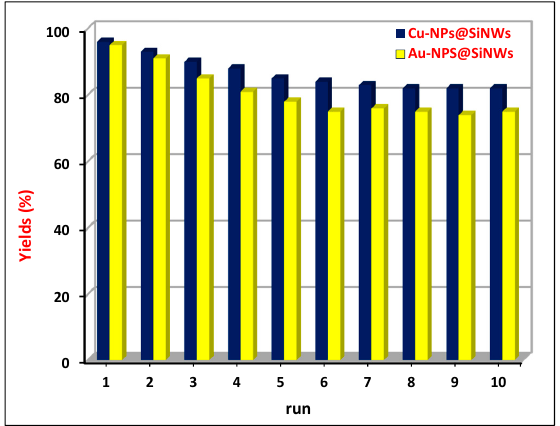
Figure 6. Recycling experiments for CuNPs@SiNWs and AuNPs@SiNWs catalysts in the C–N coupling of iodobenzene with butylamine.